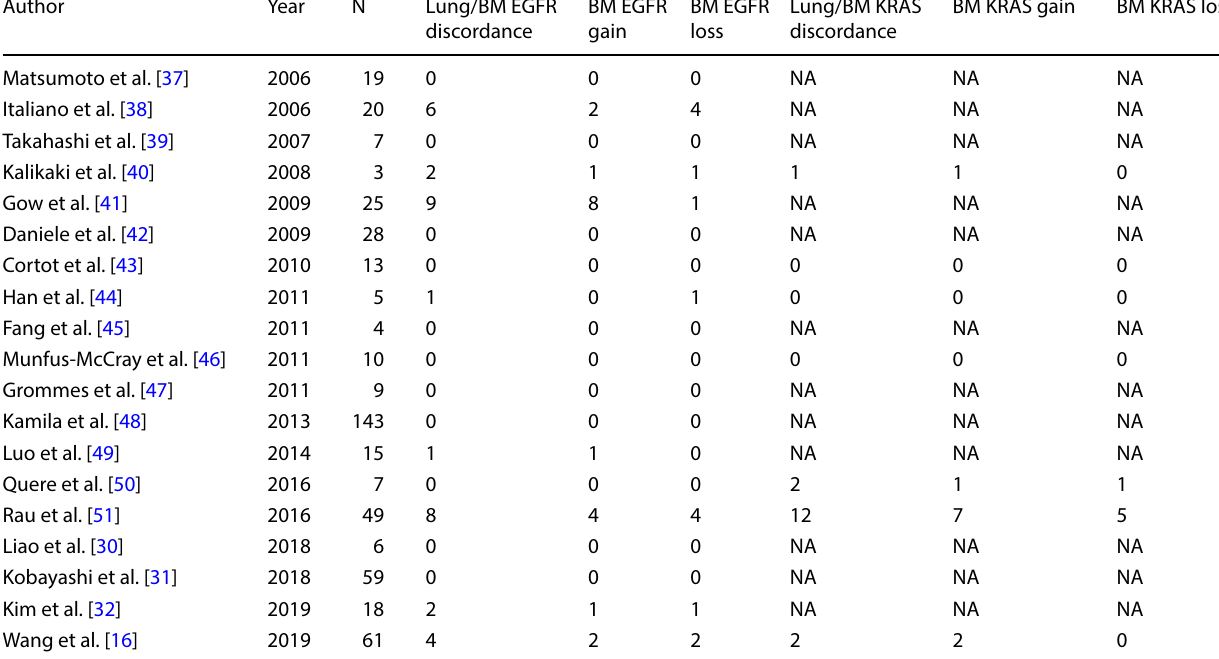
N: Number; NA: Not available; BM: Brain metastasis; EGFR: Epidermal growth factor receptor; KRAS: Kirsten rat sarcoma viral